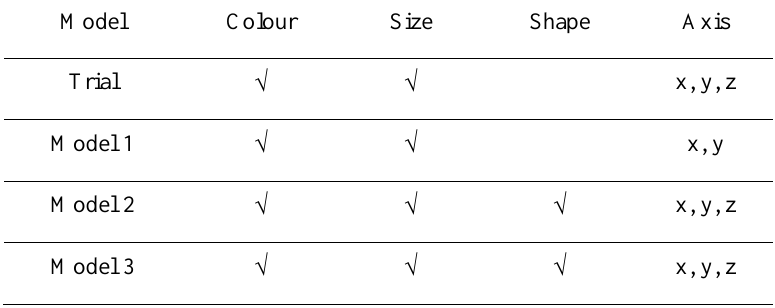
Dimensions considered in each model Model Colour Size